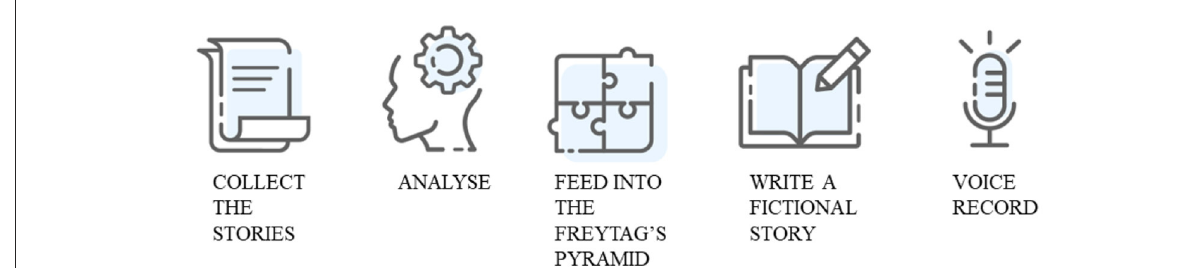
FIGURE1 Transformative Storytelling Technique steps.